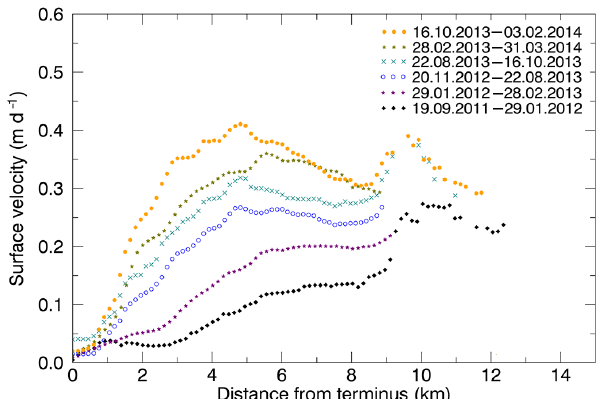
Figure 5. Longitudinal surface velocity profiles showing (from bot- tom to top) the pre-surge acceleration that occurred in the 2.5 years before the main surge onset. The profiles, derived from TanDEM-X data, follow the longitudinal path from Fig. 3. Gaps above 9km in- dicate failed velocity calculation owing to the poor surface contrast providing no clear correlation. The labels state the time period over which each velocity calculation was averaged, in this case ranging from 2 to 13